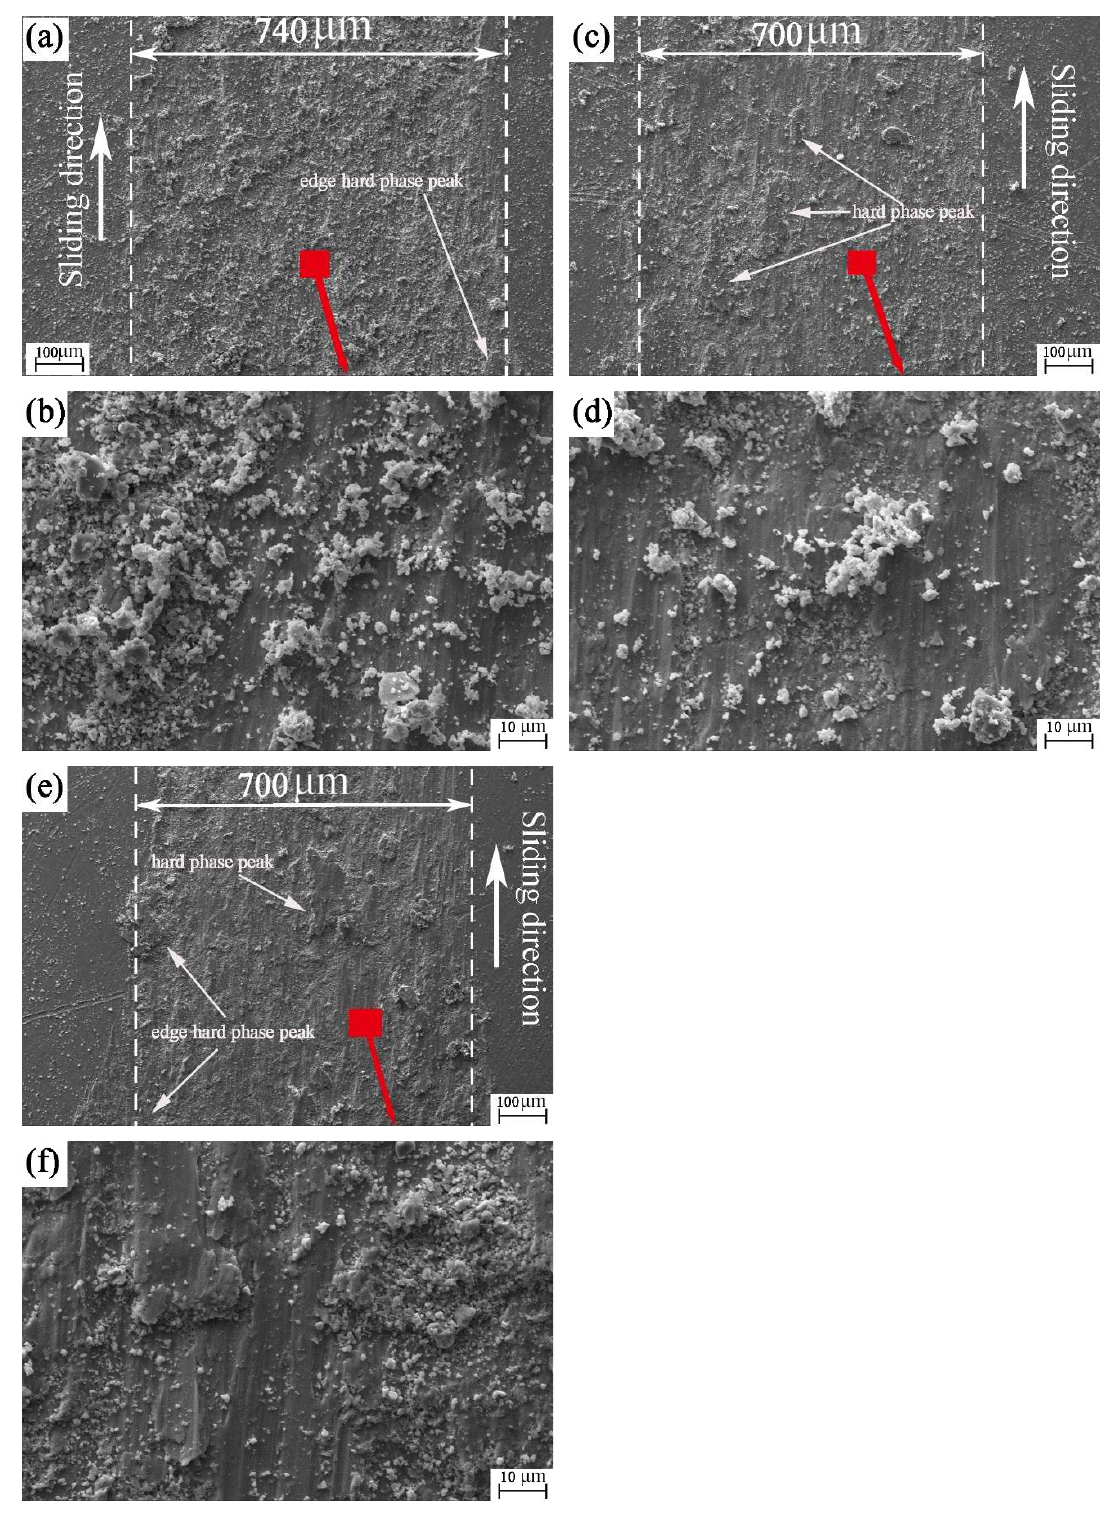
Figure 11. SEM images of the electric-spark-textured worn plates: ( a , b ) Rotation radius 15 mm; ( c , d ) Rotation radius 18 mm; and ( e , f ) Rotation radius 22.5 mm.